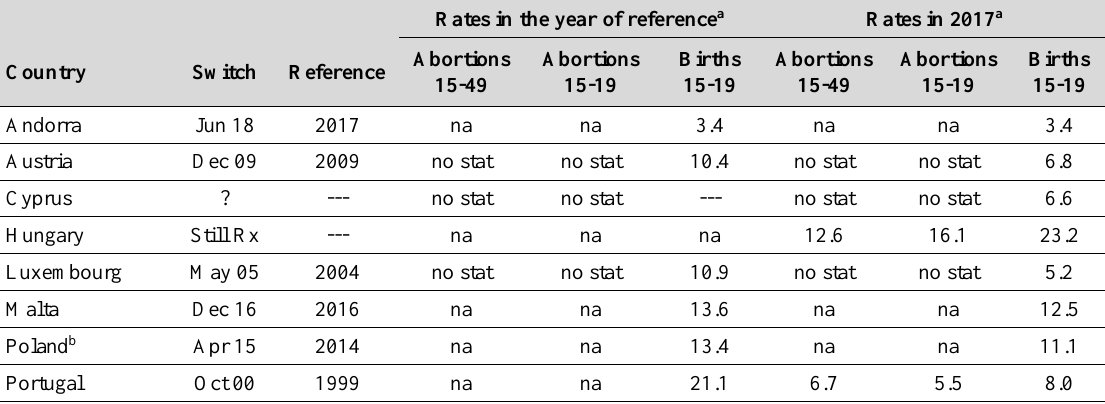
Table 2. Induced abortion and live birth rates for further European